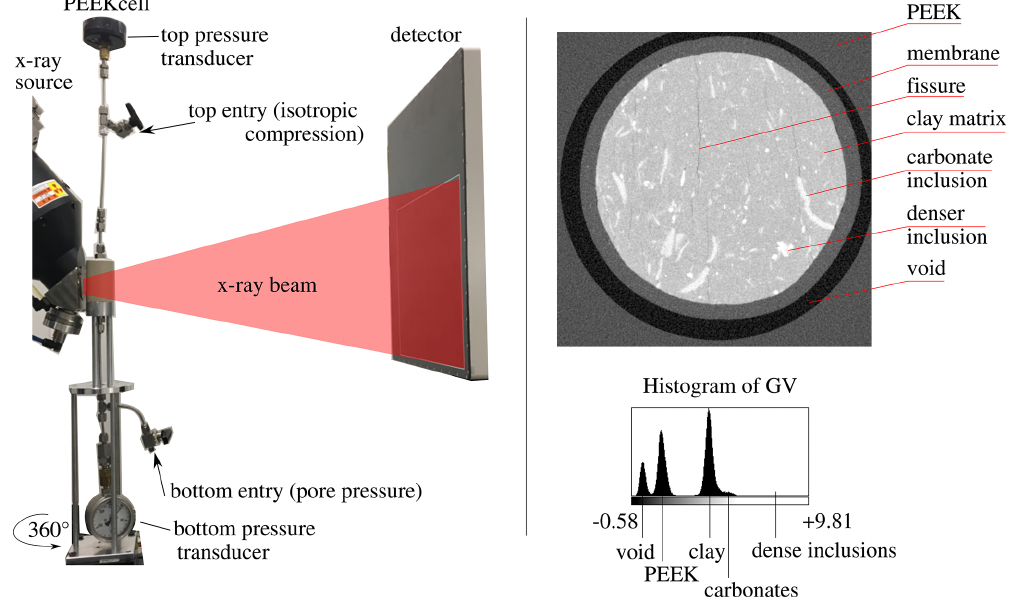
Figure 1. Left: PEEKcell set-up in the X-ray tomograph. Right: horizontal slice of a reconstructed X-ray image and the corresponding histogram of grey